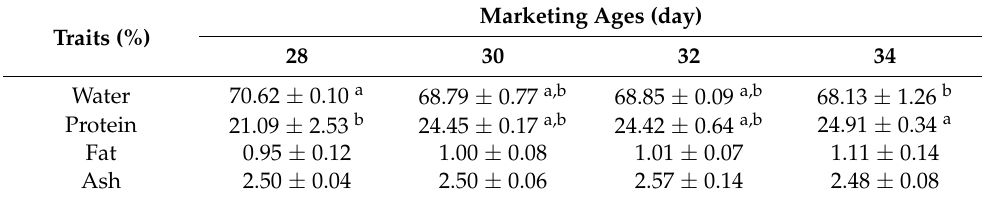
Table 1. Proximate composition of cooked cured chicken breast with various marketing ages. Traits